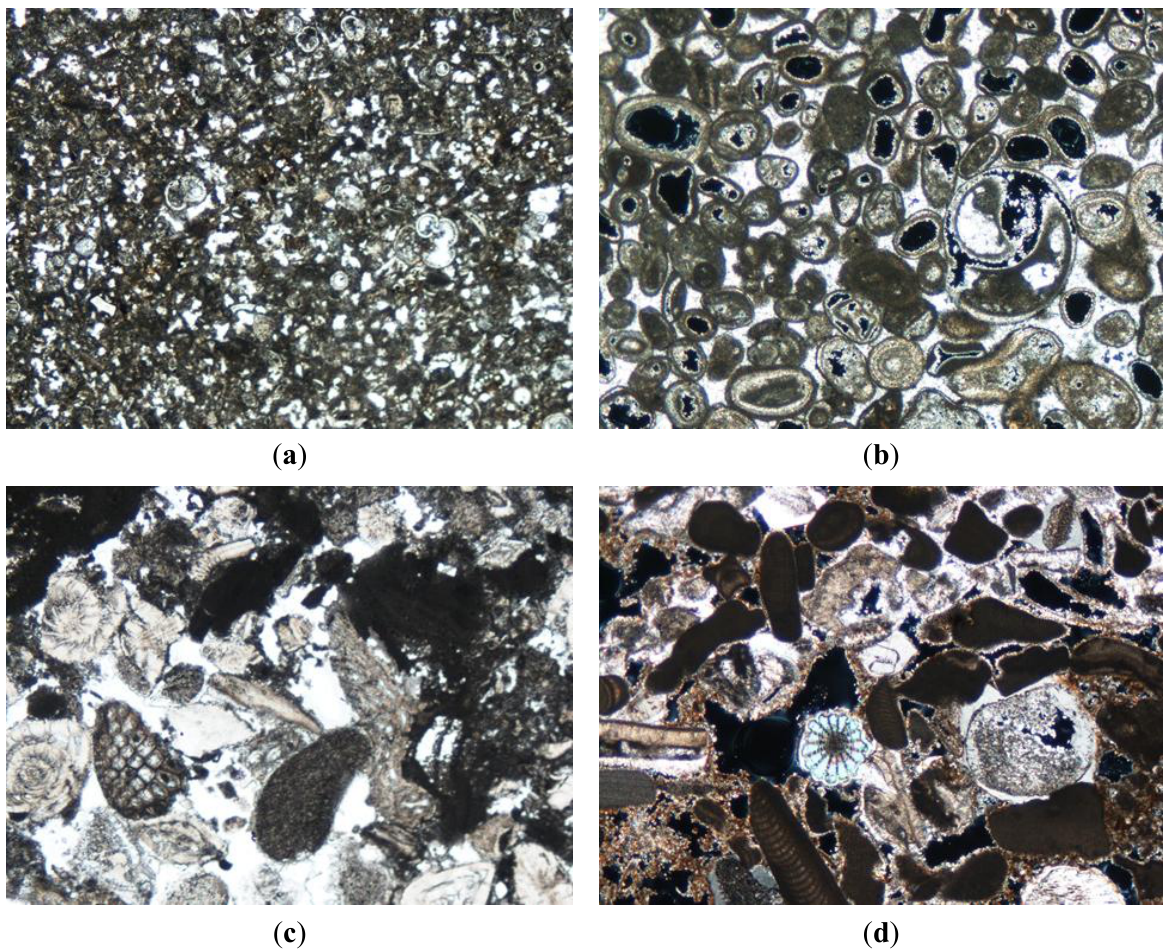
Figure 4. Microphotographs of thin section of the sample ( a ) C.1.1.1; ( b )